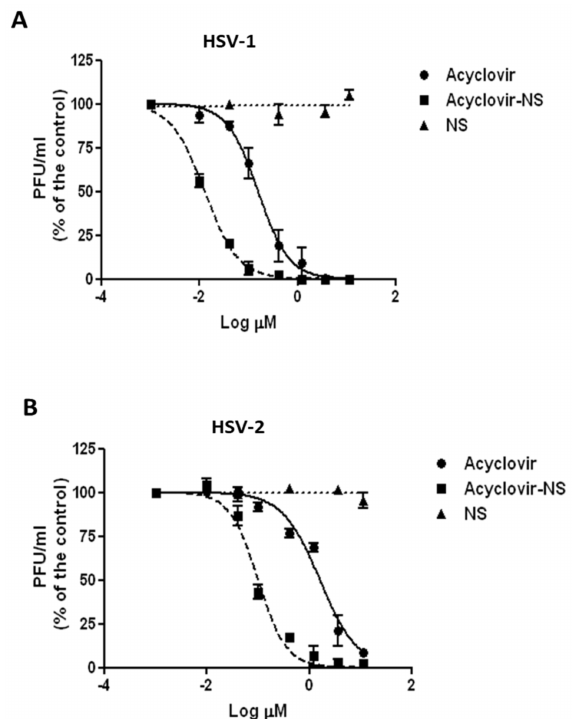
Figure 4. Antiviral activity of free acyclovir, acyclovir-loaded NS, and plain carrier (NS) against HSV-1 ( A ) and HSV-2 ( B ). Vero cells were infected at a multiplicity of infection (MOI) of 0.01 and then exposed to different drug concentrations. Virus titers in the supernatants of cell cultures were determined by a standard plaque assay at 48 h or 24 h post-infection for HSV-1 or HSV-2, respectively. Values are the means of three separate determinations.